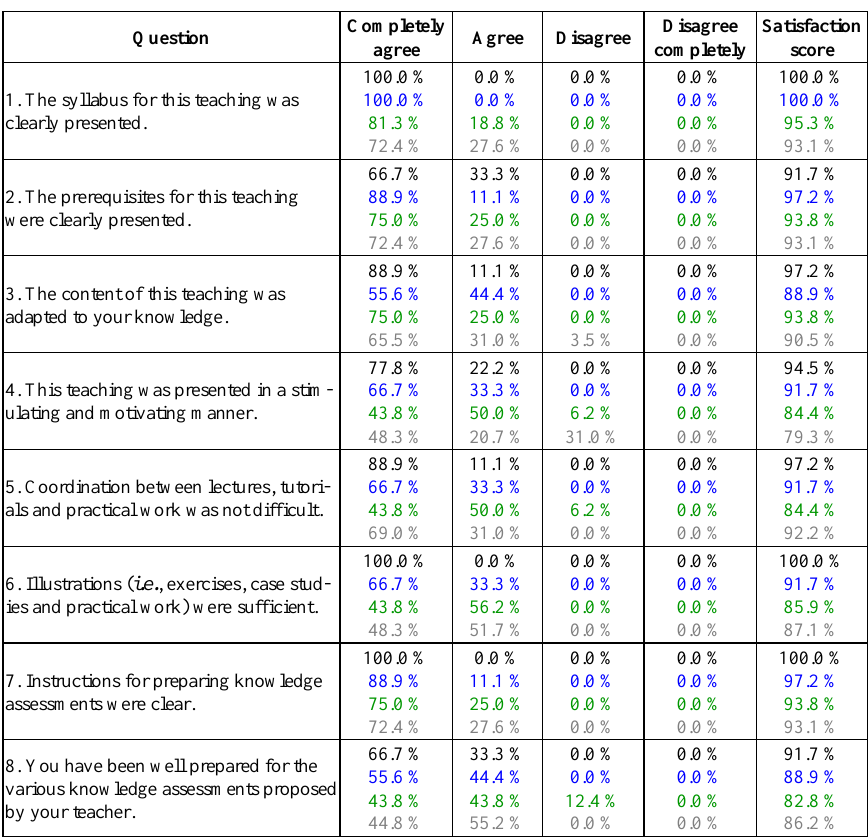
Table 3. Example of satisfaction survey results: The results for the first group (9 students completed the survey), the second group (9 students completed the survey), the third group (16 students completed the survey), and the fourth group (29 students completed the survey) are shown in black , blue, green, and gray respectively Completely Disagree Satisfaction Question Agree Disagree agree completely